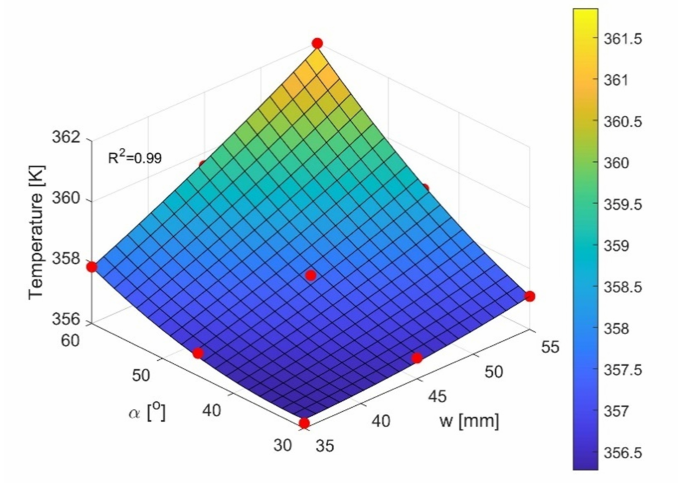
Figure 17. Temperature dependence of the heat source depending on the case under